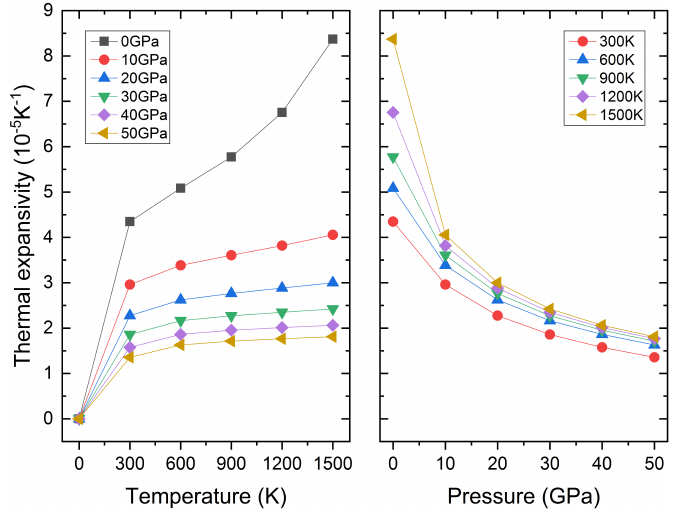
Figure 10. The thermal expansion coefficient α variation with temperature ( left ) and pressure ( right ) for Ti 2